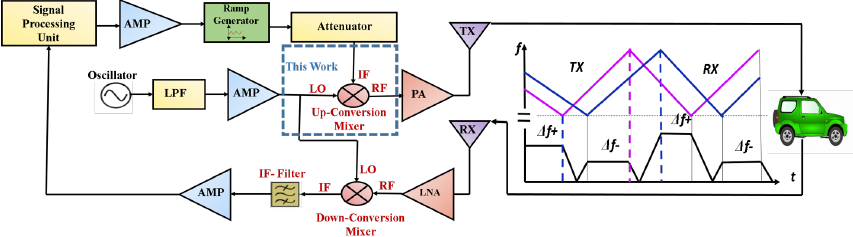
Figure 1. Block diagram of a typical radar